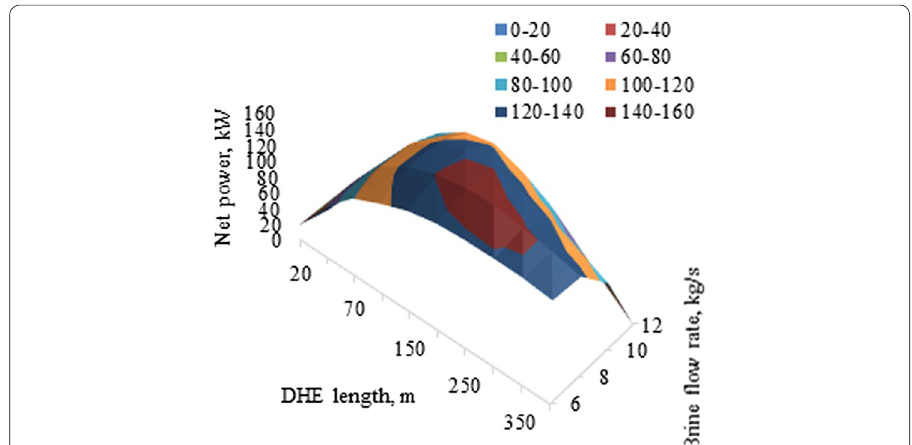
Fig. 13 Net power development for various DHE lengths and brine flow rates